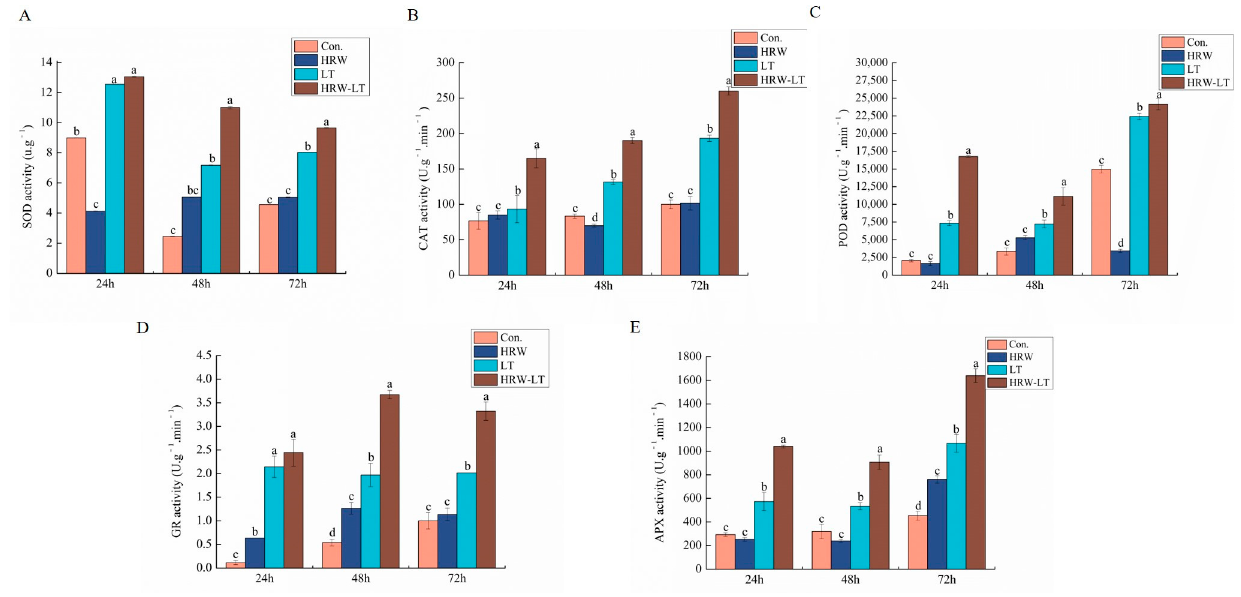
Figure 10. Effect of HRW on the enzymatic system of cucumber seedlings under chilling stress. ( A ) SOD; ( B ) CAT; ( C ) POD; ( D ) GR; ( E ) APX. Data are the mean ± standard deviation of three biological replicates. The different letters indicate a significant difference ( p < 0.05).